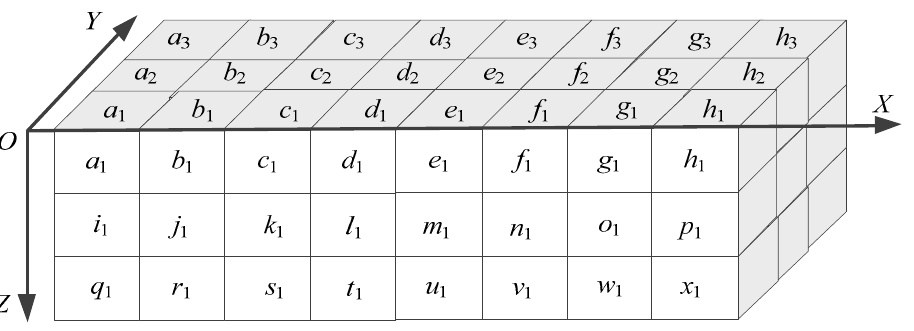
Figure 4. Illustration of the repeated accessing of voxels existing in the VP algorithm.